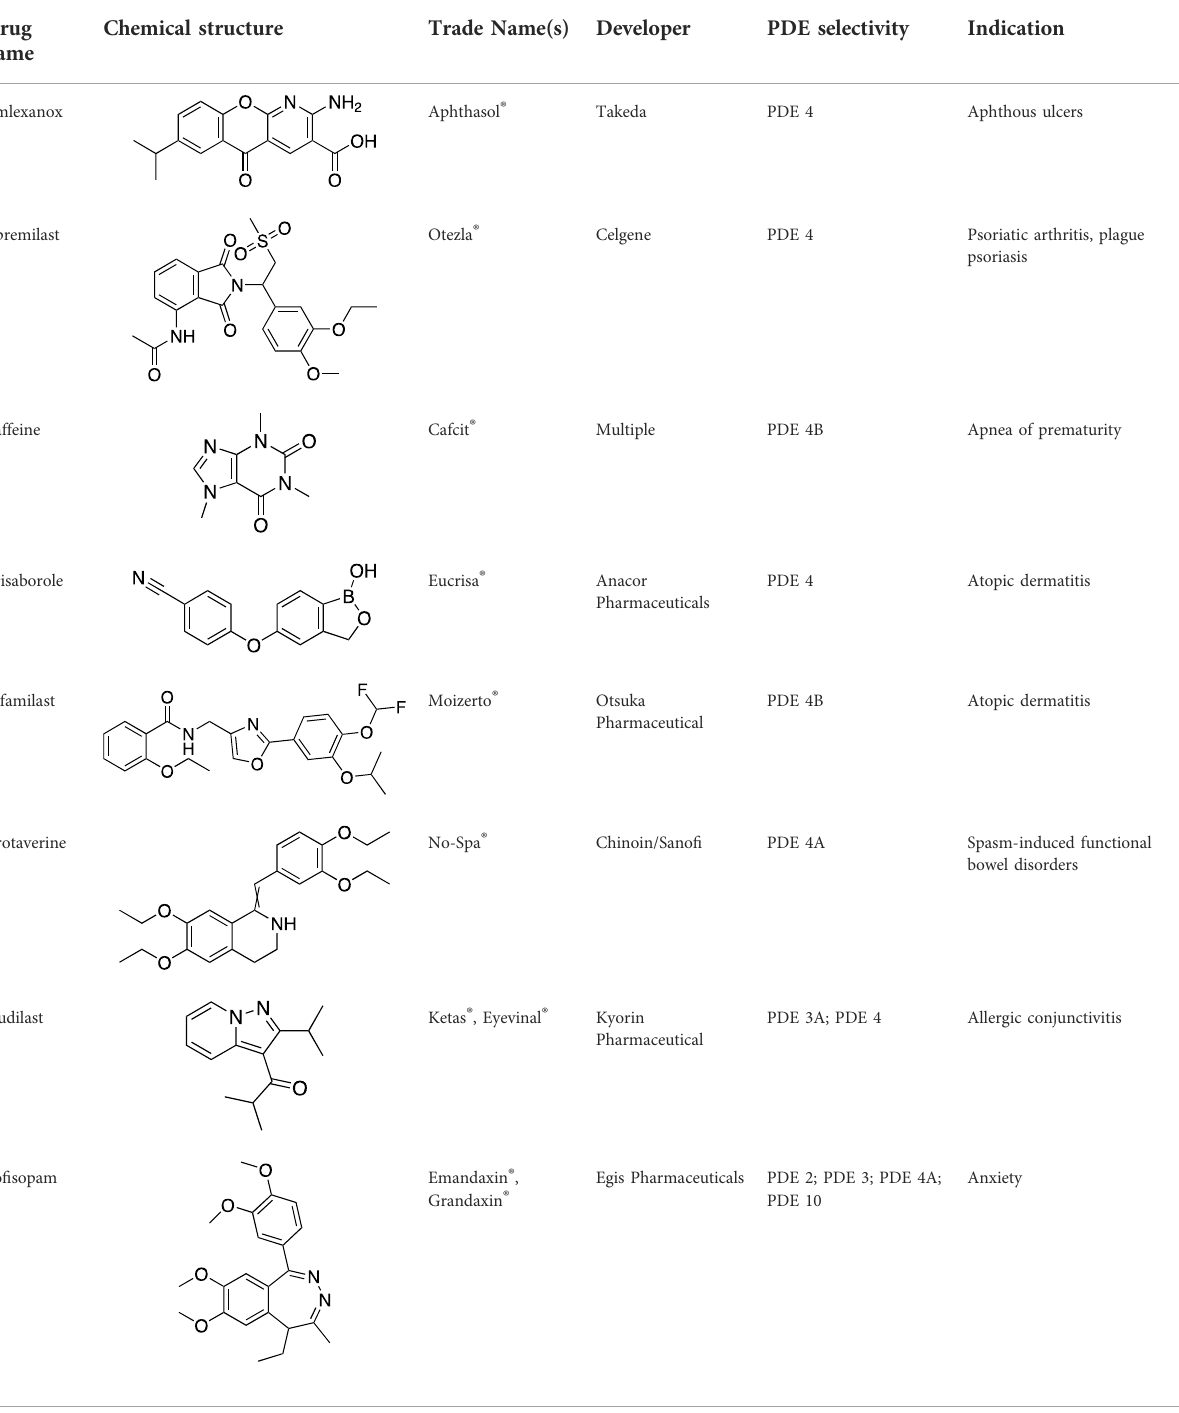
TABLE 4 Marketed PDE inhibitors in in fl ammatory and nervous system disorders. This table provides a summary on the available evidence for marketed PDE inhibitors in in fl ammatory diseases and some neurologic pathologies. Trade names, developer and the targeted PDE isozymes are listed according to the PubChem and DrugBank database records. Chemical structures are derived from the PubChem database (Kim et al.,